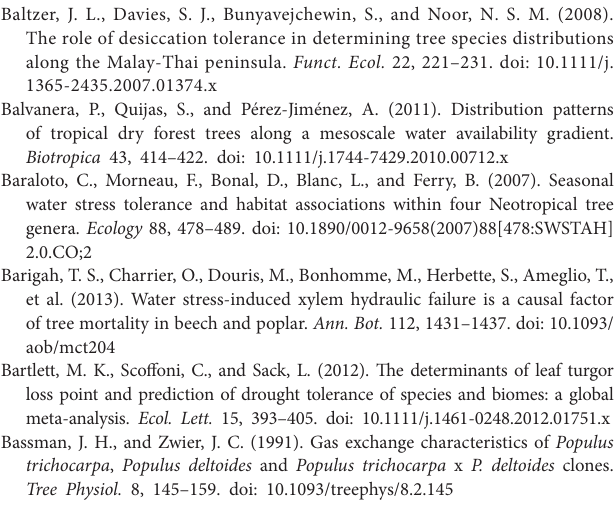
Supplementary Figure S1 | Barplot comparing soil water content (SWC) among per plot between LP and QM. Error bars represent 1 SE, and different letters indicate significant differences between regions ( p < 0.05). Supplementary Figure S2 | Relationships between Al: As and LDMC, LMA, LT of congeneric species (20 pairs of congeneric common species, 11 pairs of congeneric endemic species and 31 pairs of congeneric species) in Loess plateau (LP; low soil water availability; closed circles) and Qinling Mountain (QM; high soil water availability; open circles). Linear regressions were fitted to the data (black regression lines, LP; red regression lines, QM). Values of R2 are followed by significance level (*, p < 0.05; **, p < 0.01; and ***, p < 0.001). Values of K represent slopes of lines. Supplementary Figure S3 | Relationships between SD and LMA, LT, Pmax. Supplementary Figure S4 | Relationships between Ψ Tlp and LDMC, LMA, LT, Pmax. Supplementary Figure S5 | Relationships between Vdmax and LMA, TD. Supplementary Figure S6 | Relationships between WSGbranch and LDMC, LMA,